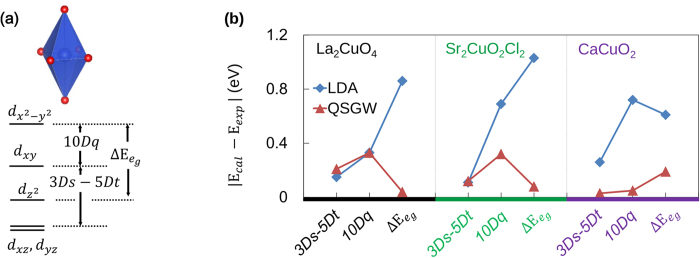
(a) The three model parameters for the comparison to Ref. 32. Note that  is denoted by 4Ds + 5Dt in Ref. 32. (b) The difference of the calculated model parameters (Ecal) from the experiments (Eexp).